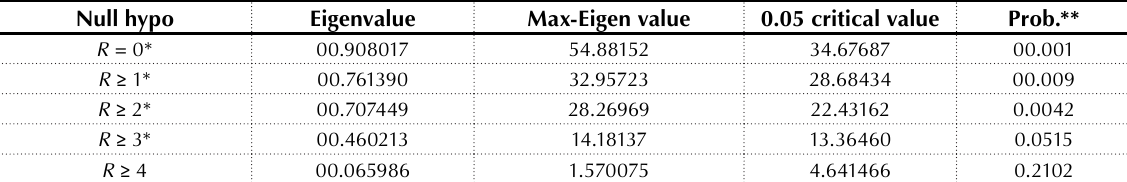
Table 3B. Maximum Eigenvalue